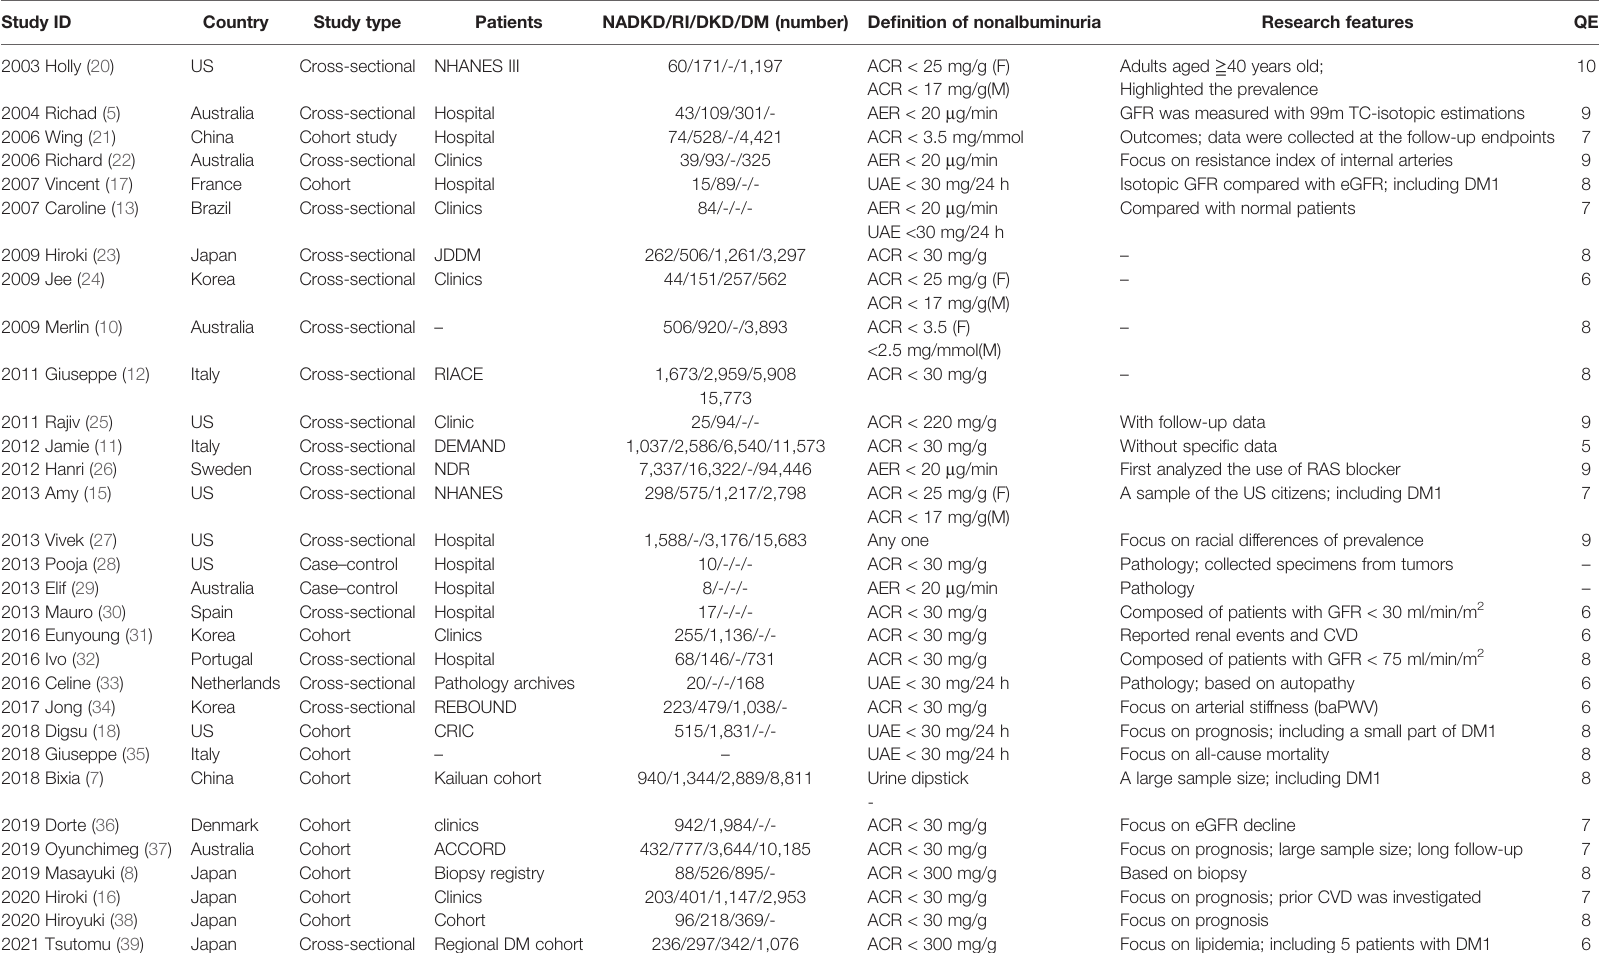
IDindicatesidentity;NADKD,nonalbuminuriadiabetickidneydisease;IR,renalinsuf fi ciency(GFR<60ml/min/1.73m 2 );DKD,diabetickidneydisease;DM,diabetesmellitus;DM1,type1diabetes;US,UnitedStates;NHANESIII,theThird NationalHealthandNutritionExaminationSurvey;ACR,albuminuriacreatinineratio;AER,albuminexcretionrate;GFR,glomerular fi ltrationrate;UAE,urinaryalbuminexcretionduring24h;eGFR,estimatedglomerular fi ltrationrate;JDDM, Japan Diabetes Clinical Data Management; RIACE, The Renal Insuf fi ciency And Cardiovascular Events; DEMAND, Developing Education on Microalbuminuria for Awareness of Renal and Cardiovascular Risk in Diabetes; RAS, renin – aldosterone system; NDR, Swedish national diabetes register; NHANES, the National Health Nutrition Examination Survey; CVD, cardiovascular disease; REBOUND, a multicenter prospective observational study conducted from December 2008 to December 2010 in Korea; baPWV, brachial-ankle pulse wave velocity; CRIC, chronic renal insuf fi ciency cohort study; ACCORD, Action to Control Cardiovascular Risk in Diabetes clinical trial; QE, literature quality evaluation; -, no record. (Since renal biopsy is not always applicable and rarely performed and three studies based on pathology had small samples, their quality was not evaluated; details are shown in Appendix Table 2 , 3